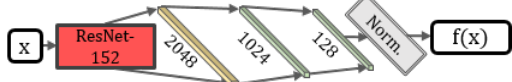
Figure 1. CNN architecture. An image x is passed through a ResNet-152 and two FC layers with 1024 and 128 dimensions, respectively. Normalization (Norm.) of the output of the last FC layer delivers a 128-dimensional feature vector f ( x )